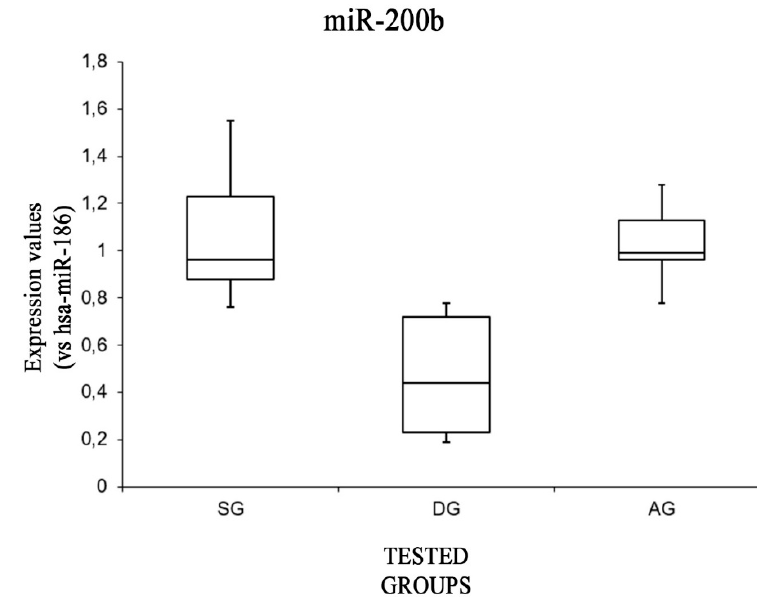
Figure 2. Box plot analysis showing the expression levels of miR-200b (endogenous control miR-186) in each group.